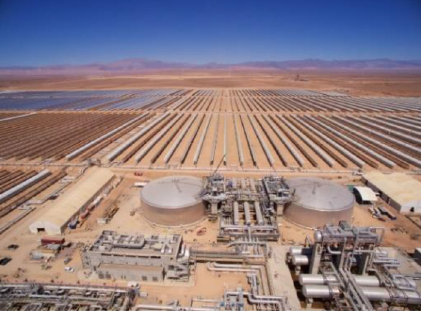
Fig. 15. Moroccan Ourzazate solar